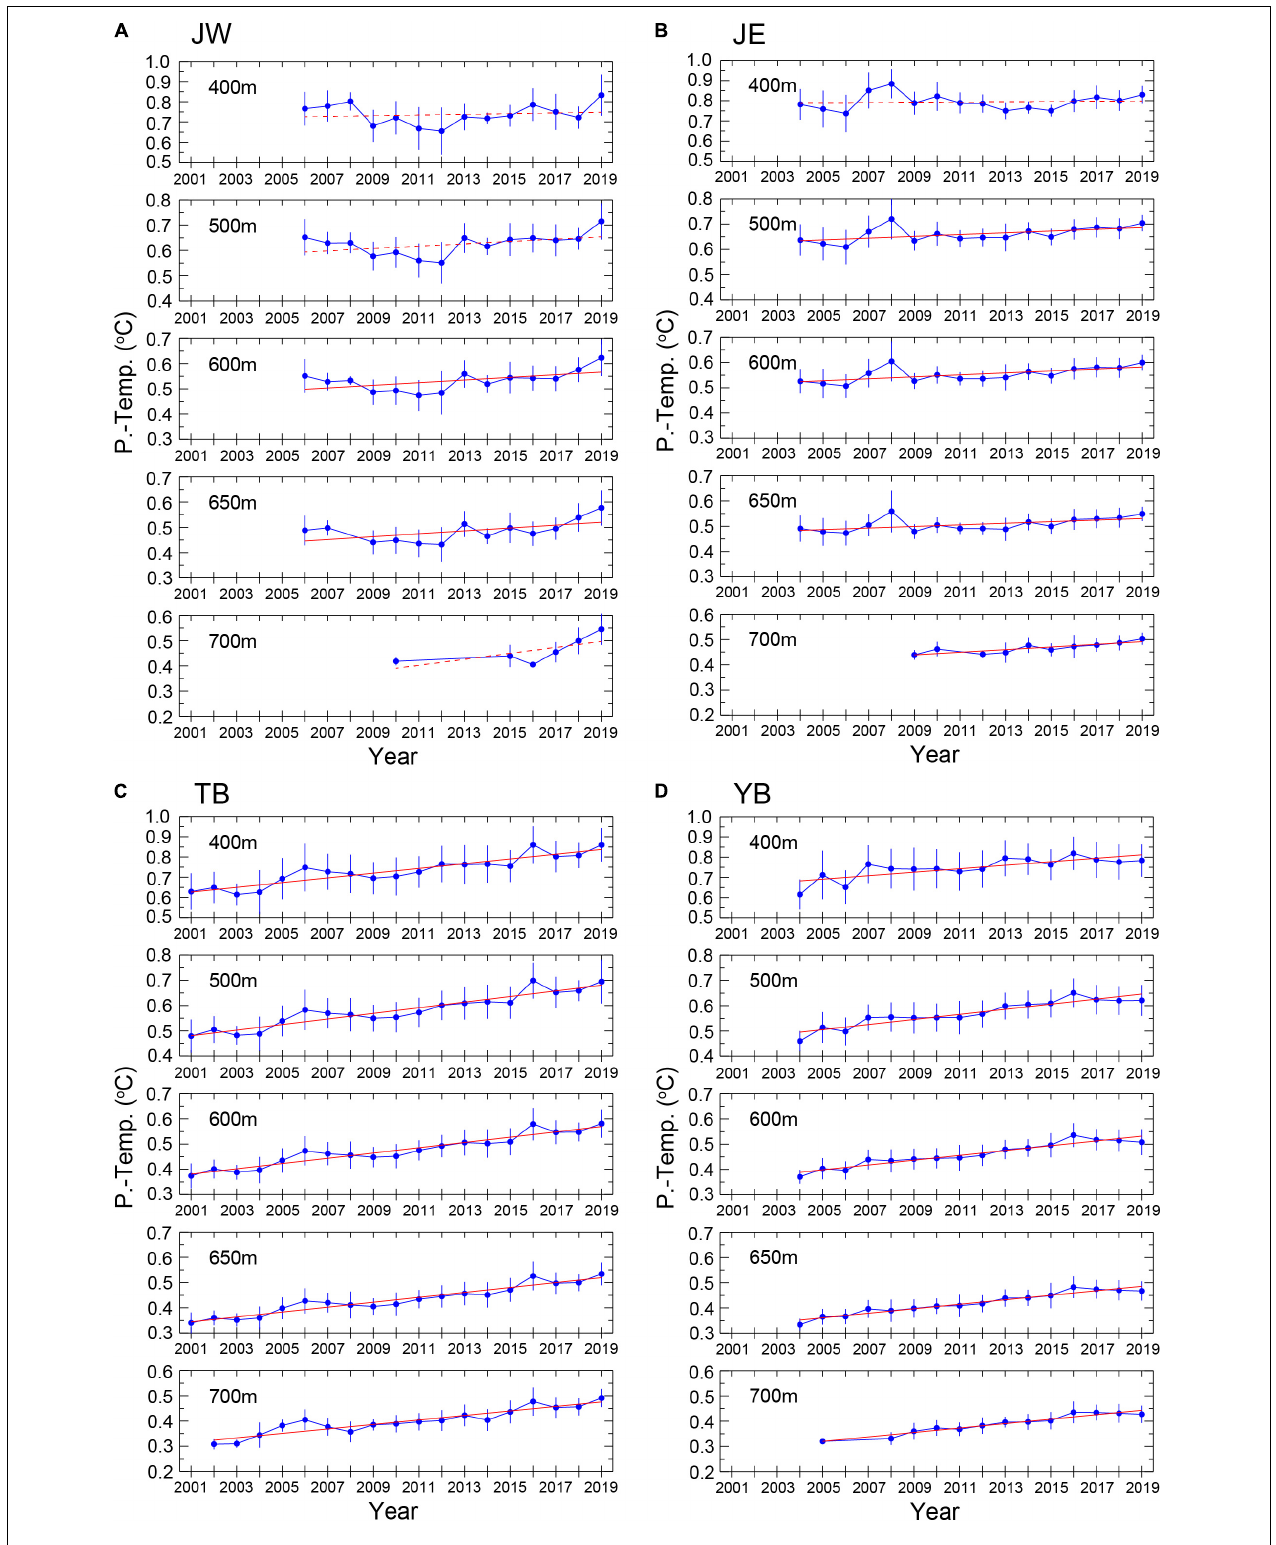
FIGURE 4 | Time series of the Argo-based yearly mean PT at 400, 500, 600, 650, and 700 m in (A) JW, (B) JE, (C) TB, and (D) YB. Vertical bars at each data point indicate one standard deviation. Red lines depict the linear trend calculated by least square method. Statistically insignificant trends at 95% confidence level are shown by dashed